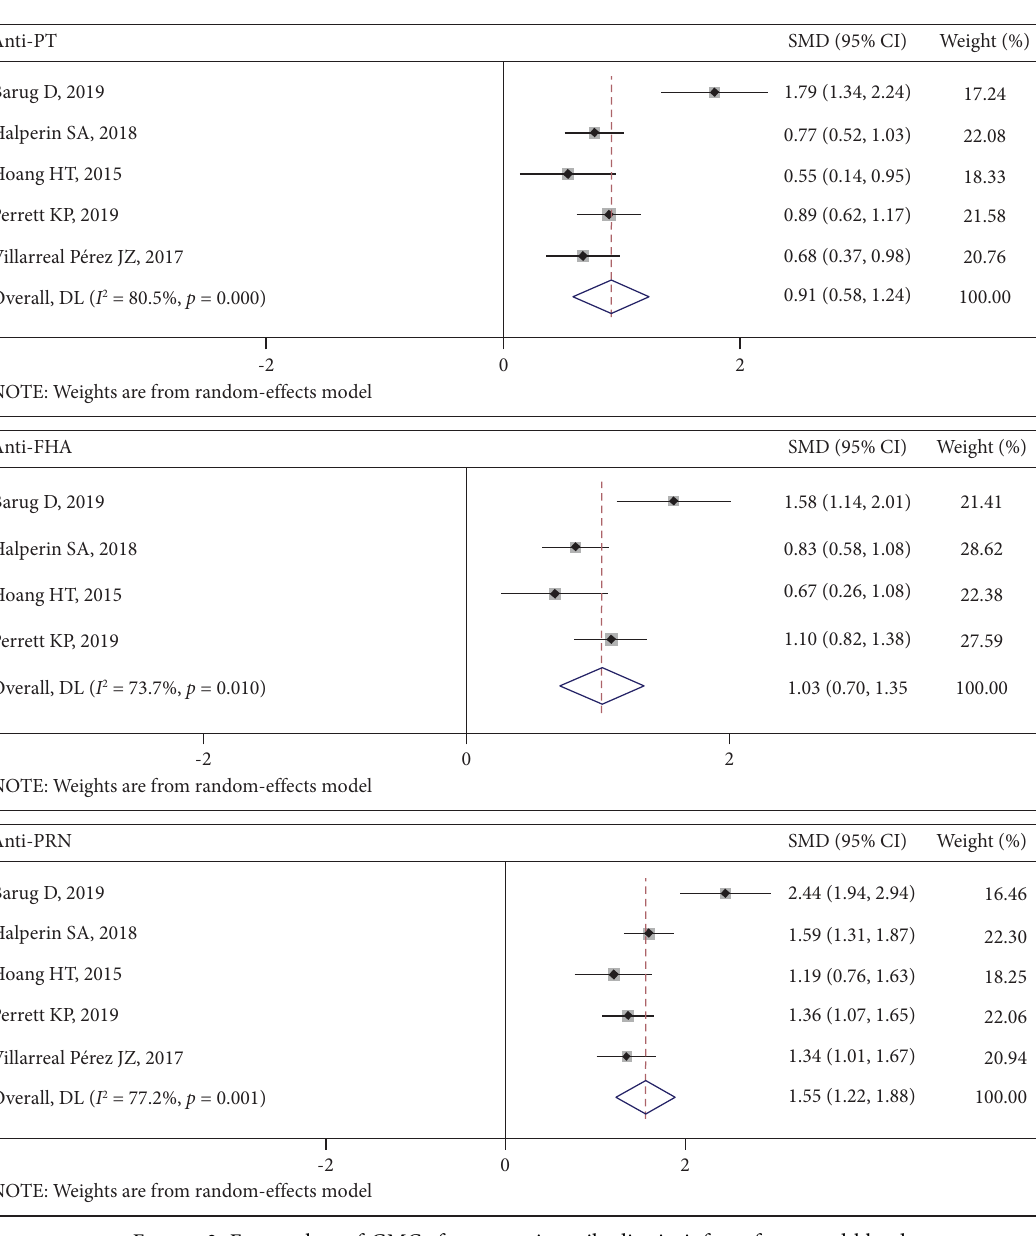
Figure 2: Forest plots of GMCs for pertussis antibodies in infants from cord